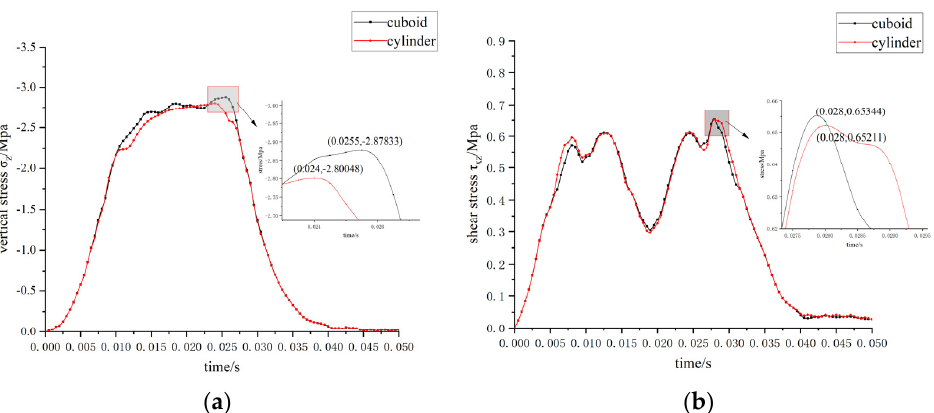
Figure 13. Maximum stress–time curve of elements at the interface under different sensor shapes. ( a ) σ z -time; ( b ) τ xz -time.